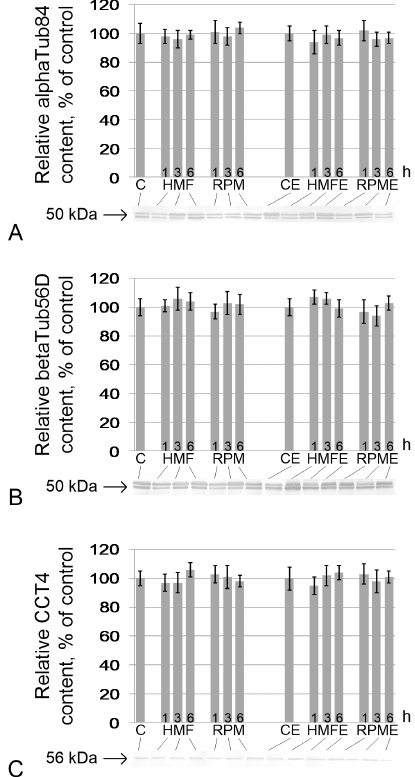
Figure 3. Relative content of proteins and components of the sperm tail axoneme. ( A ) alphaTub84, alpha-tubulin84D, and alpha-tubulin84B (50 kDa), components of the tubulin heterodimer; ( B ) betaTub56D, beta-tubulin (50 kDa), component of the tubulin heterodimer; ( C ) Cct4 (CG5525), chaperonin containing Tcp1 subunit 4-delta (56 kDa), participates in the assembly of tubulin heterodimers. Typical western blots for each protein are performed under the according histogram. Similarly, no changes were noted in the content of proteins involved in ATP generation. There were no changes in the relative contents of cytochrome c (Figure 4A), cytochrome c oxidase (Figure Int. J. Mol. Sci. 2020 , 21 , x FOR PEER REVIEW 4B), blw (the catalytic subunit F1 ATP synthase) (Figure 4C), and gapdh (Figure 4D) in the HMF and RPM groups, as well as in HMFE and RPME up to 6 h of exposure.